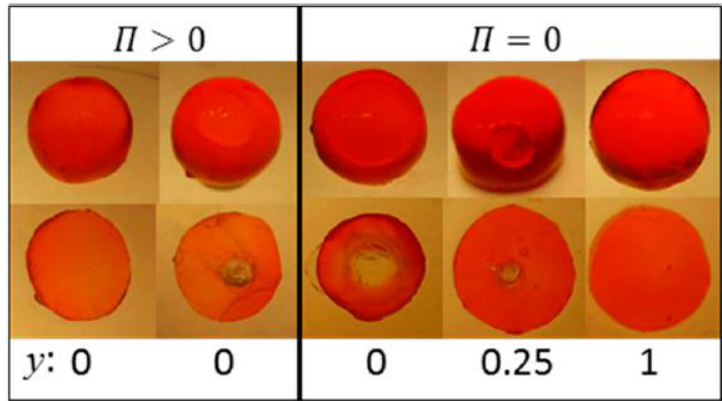
Figure 18. Pictures of intact gels (upper row) and slices through the center of each gel (lower) form the paper by A&H. Pictures to the right of the vertical bar show gels with β = 0.5 in equilibrium with pure water ( Π = 0) at di ff erent non-ionic-to-cationic surfactant ratios ( y ) as indicated by the number under each column. Pictures to the left of the bar show two di ff erent gels with β = 0.5 and y = 0 after drying ( Π > 0). The gel to the far left was dried for the longest period; both gels were initially in equilibrium with pure water. Micelle-rich regions are stained red by the presence of small amounts of oil orange in all gels. Figure taken from ref. [22]. Reprinted with permission. Copyright 2017 American Chemical Society.